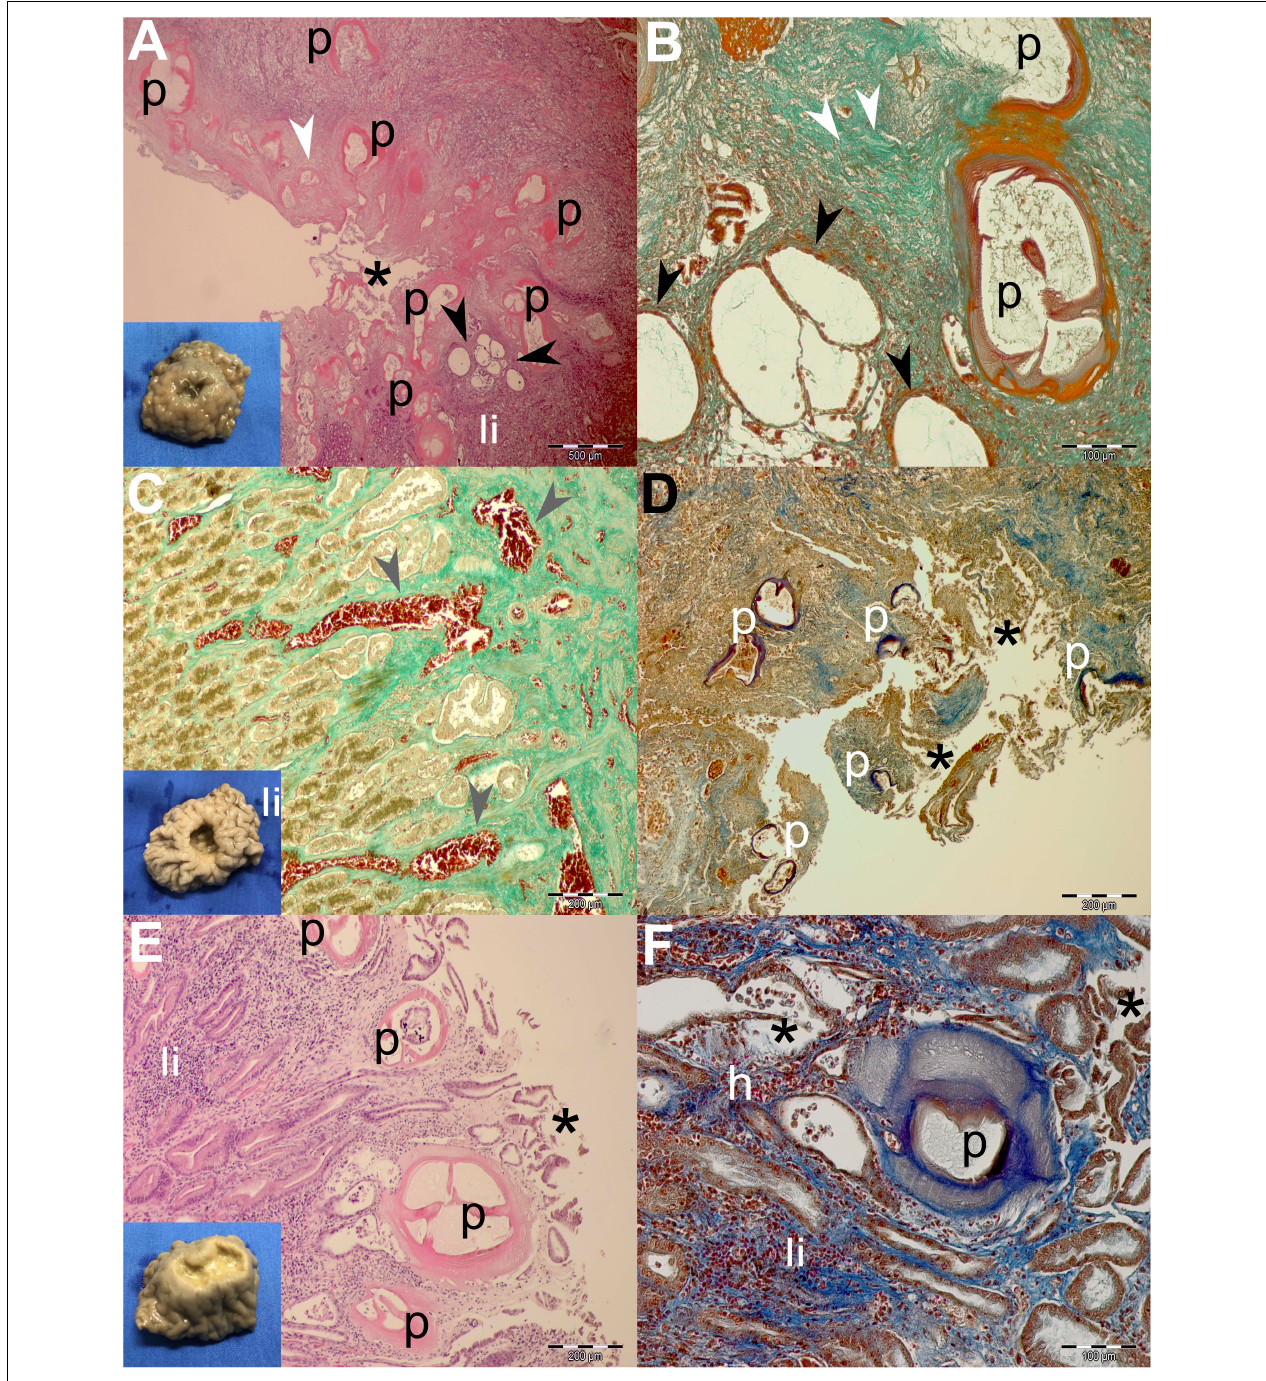
FIGURE 4 | Gross pathological (insets) and histopathological findings of gastric lesions in California sea lions ( Zalophus californianus ) necropsied at the Marine Mammal Care Center in San Pedro, California, United States (spring and summer 2017 and 2018), affected by parasites of Anisakidae family. (A) Multiple anisakid parasitation site showing transversal sections of the parasites, necrotic epithelium, granulation, mixed leukocytic infiltration, and coalescence of cystic gastric acini. (B) Higher magnification of the previous section showing coalesced gastric acini forming large cysts, which consist of a single atypical cell layer and intraluminal net-like secretion and few cells, stained by Mallory trichrome stain (MTS). (C) Hemostasis in the lamina propria beneath multiple anisakid attachment in a deep ulcer. (D) Severe necrosis in a multiple anisakid ulceration affecting the tunica submucosa. (E) Mild necrosis in a shallow gastric ulcer parasitized by multiple anisakids affecting the tunica mucosa. (F) Higher magnification of the same specimen surrounded by mixed leukocyte infiltration, mild hemorrhaging, and coalescing acini. h, hemorrhage; li, mixed leukocytic infiltrate; p, parasite; *, necrosis; white arrowheads, connective tissue fibrosis; black arrowheads, ectasis of gastric acini; gray arrowhead, hemostasis. Scale bars: 100 (B,F) , 200 (C–E) , and 500 µ m (A) . Staining: H&E (A,E) , MTS (D,F) , and MTS (B,C,D,F) .